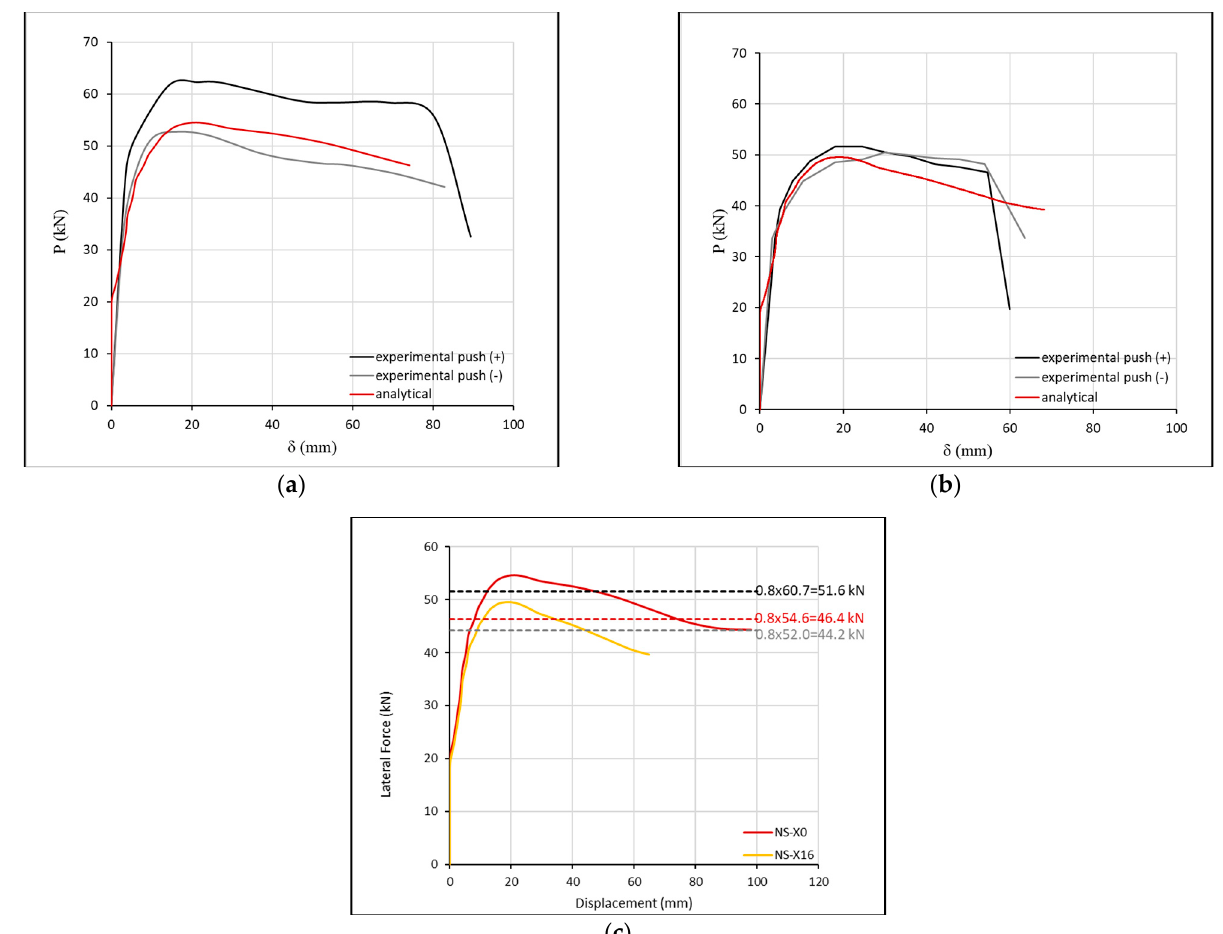
Figure 5. Comparative experimental (the envelope P- δ curve of the original experimental response) and analytical base shear force–displacement curve for specimens ( a ) NS-X0, ( b ) NS-X16; ( c ) The comparison of their analytical P- δ curves. Table 2. Comparative results for specimens NS-X0, NS-X16, CS-0 and CS-C2 with different corrosion levels.